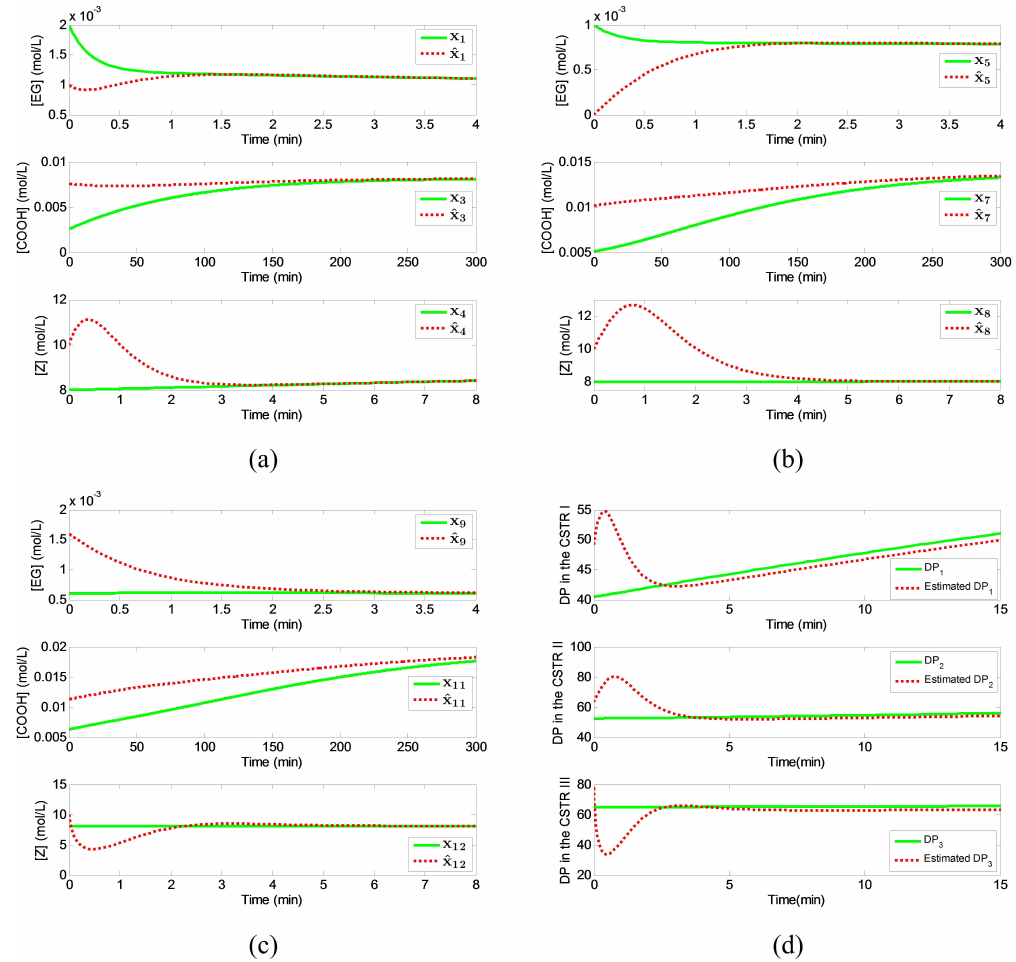
Figure 5. Performance of the reduced-order observer with “fast” eigenvalues: ( a ) actual and estimated states in CSTR I; ( b ) actual and estimated states in CSTR II; ( c ) actual and estimated states in CSTR III; ( d ) actual and estimated degree of polymerization in all three